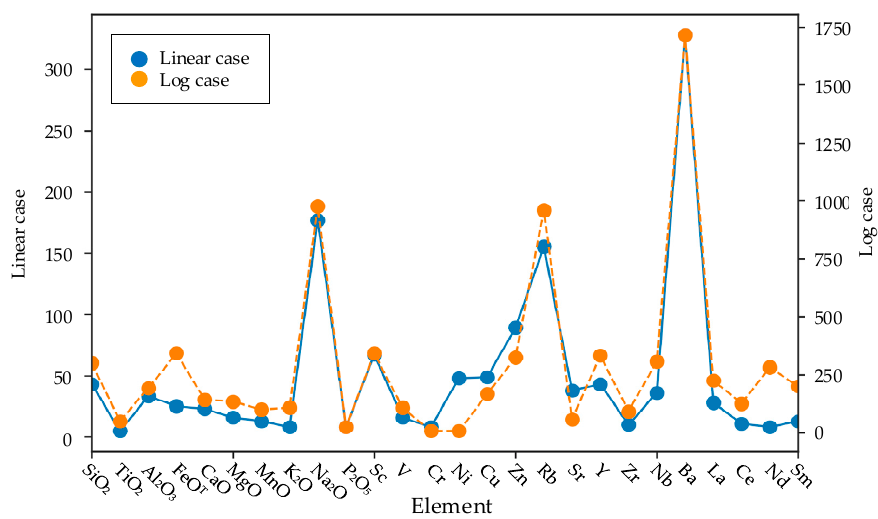
Figure 19. Statistics of the frequency of occurrence of the 26 basic elements in useful MORG and non-MORG discrimination diagrams.